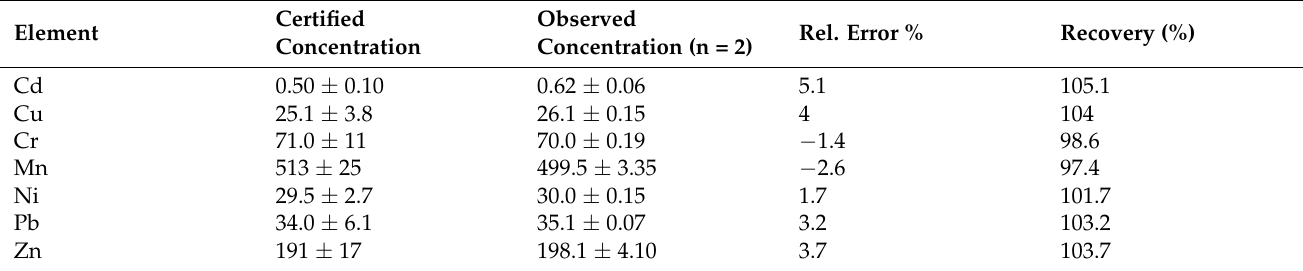
Table A2. Concentrations of Cd, Cu, Cr, Mn, Ni, Pb, and Zn (mg/kg ± S.D. in dry weight) in certified reference material (MESS-1) from the National Research Council Canada (NRC).